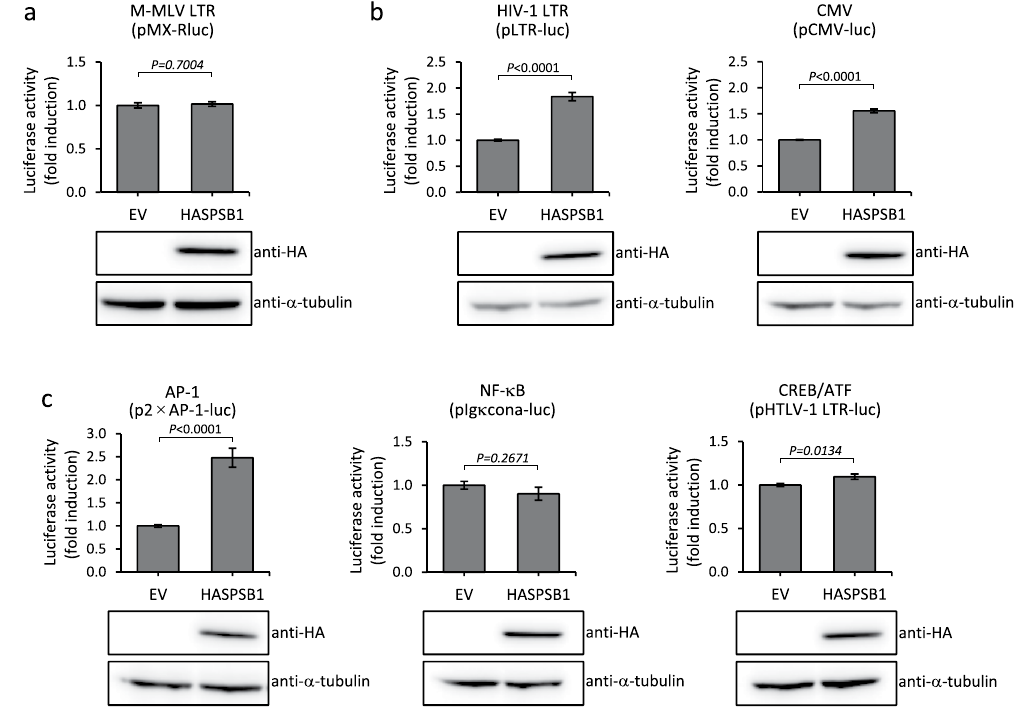
Figure 2. SPSB1 activates the HIV-1 LTR and CMV promoter. ( a ) Approximately 2 × 10 5 HEK293T cells were co-transfected with 0.1 μ g of pMX-Rluc and 0.2 μ g of EV or pHASPSB1 (HASPSB1). Transfected cells were harvested 24 hours post-transfection. The luciferase activity was normalized against the protein concentration and the results are shown as fold-increase compared to the EV (upper panel). The bars indicate the standard errors calculated from three independent experiments. Thirty μ g of cell lysates were subjected to western blotting with anti-HA or anti- α -tubulin antibodies. ( b ) Approximately 2 × 10 5 HEK293T cells were co-transfected with 0.1 μ g of pLTR-luc (left panel), or pCMV-luc (right panel) together with 0.2 μ g of EV or pHASPSB1. pMX-Rluc (0.05 μ g) was co-transfected in each sample as an internal control to normalize transfection efficiency. The firefly luciferase activity was normalized to Renilla luciferase activity and the results are shown as fold-increase compared to the EV (upper panels). The bars indicate the standard errors calculated from three independent experiments. Thirty μ g of cell lysates were subjected to western blotting with anti-HA or anti- α -tubulin antibodies. Full-length blots are presented in Supplementary Fig. S4. ( c ) Approximately 2 × 10 5 HEK293T cells were co-transfected with 0.1 μ g of p2 × AP-1-luc (left panels), pIg κ cona-luc (middle panels) or pHTLV-1 LTR-luc (right panels) together with 0.2 μ g of EV or pHASPSB1. pMX-Rluc (0.05 μ g) was co-transfected in each sample as an internal control to normalize transfection efficiency. The firefly luciferase activity was normalized to Renilla luciferase activity and the results are shown as fold-increase compared to the EV (upper panels). The bars indicate the standard errors calculated from three independent experiments. Thirty μ g of cell lysates were subjected to western blotting with anti-HA or anti- α -tubulin antibodies. Relative luciferase activities are shown with average and standard error calculated from four independent experiments. One representative set of western blotting results is shown. Full-length blots are presented in Supplementary Fig.